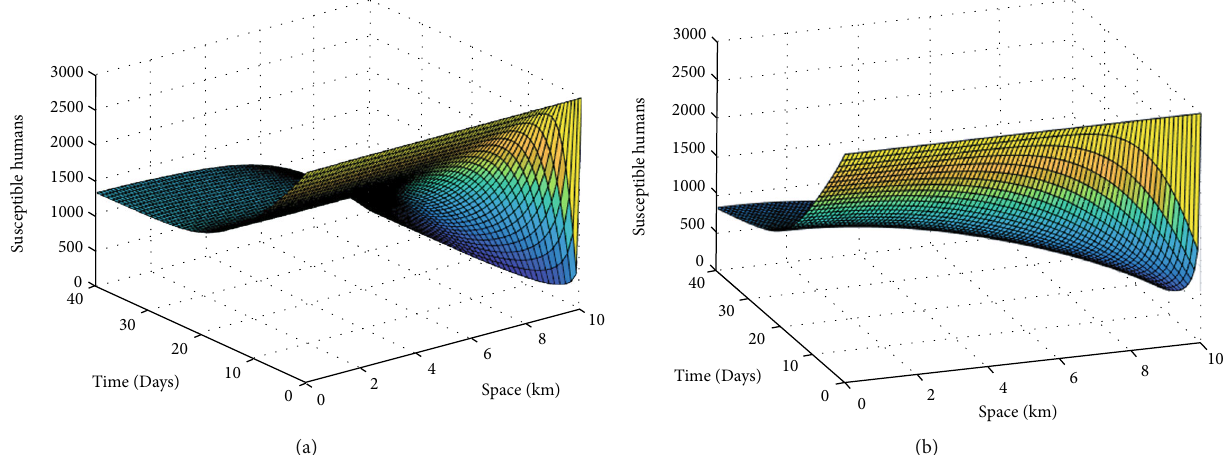
= 0 : 1 km day − 1 , and (b) 1